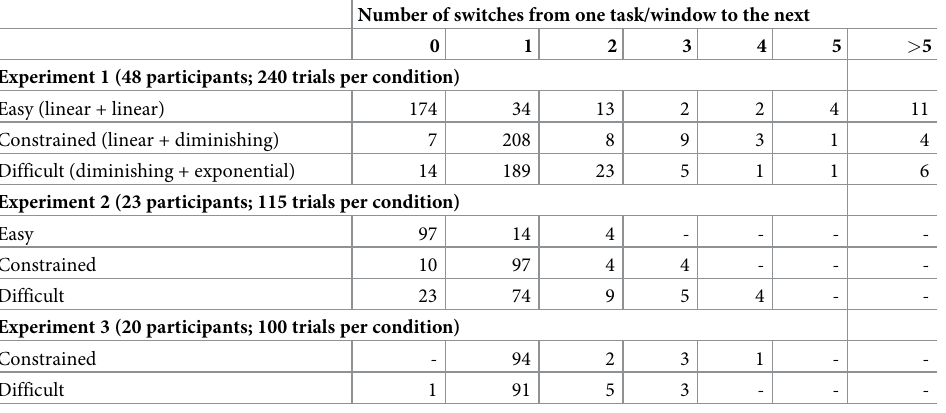
Table 1. Number of switches between windows per experiment. Number of switches from one task/window to the next Experiment 1 (48 participants; 240 trials per condition) Easy (linear + linear) 174